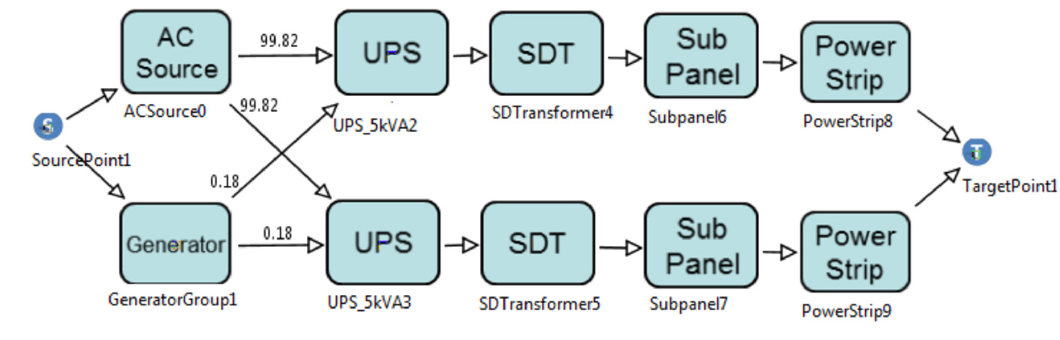
Figure 18. EFM of